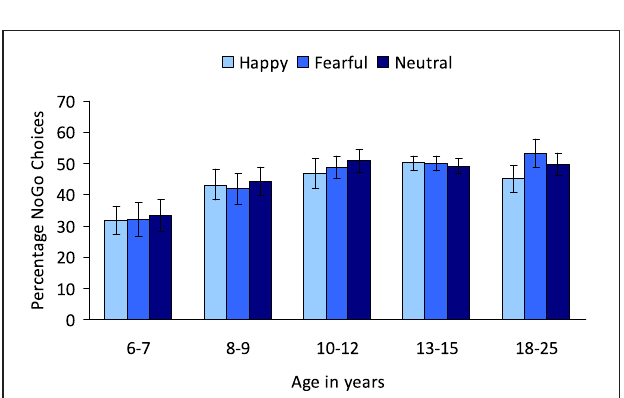
FIGURE 6 | Percentage nogo choices on the colored emotional go/nogo task. Participants were instructed to respond to colors and emotion was an irrelevant dimension.